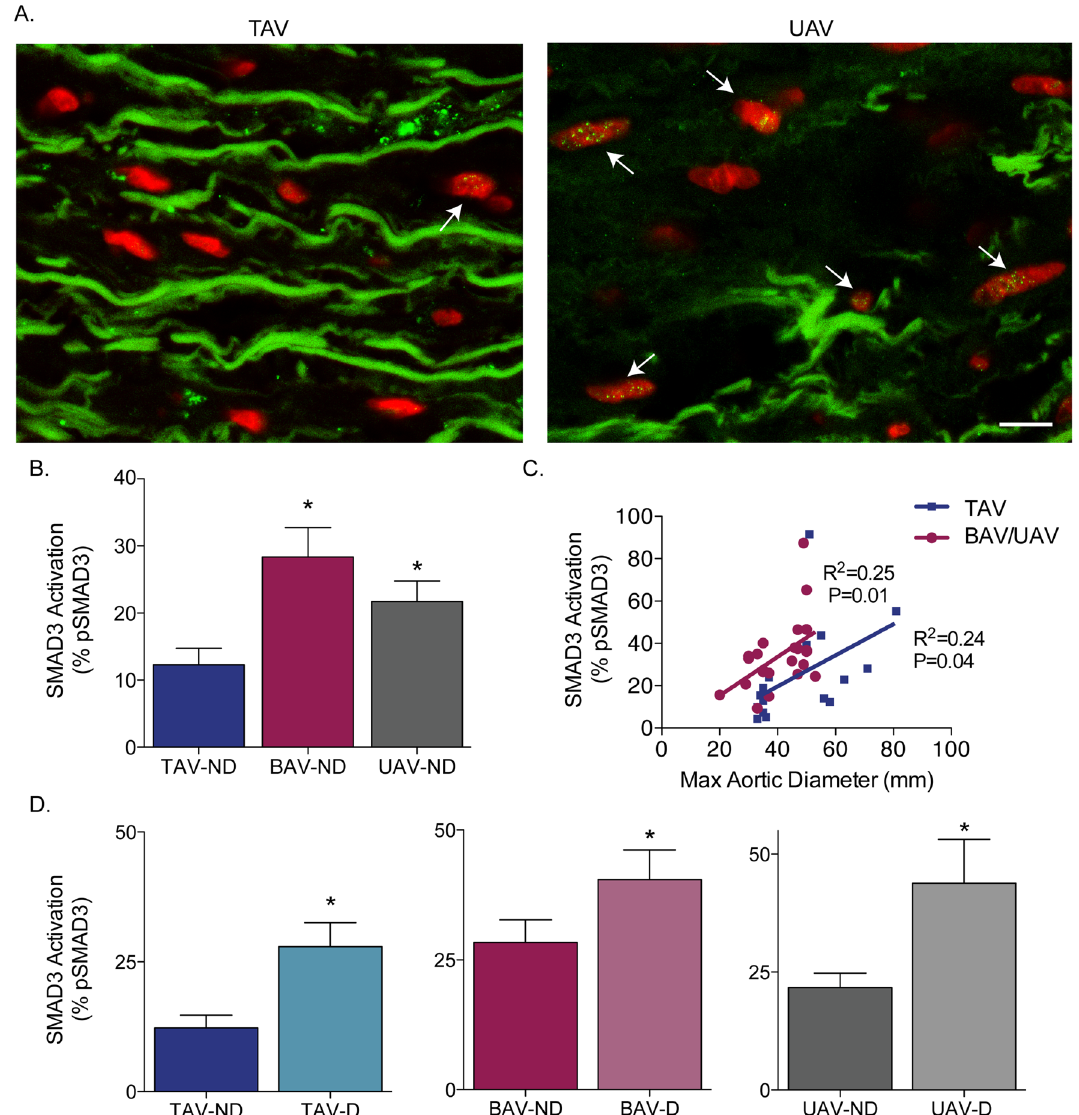
Figure 3. SMAD3 phosphorylation is increased in non-dilated bicuspid (BAV) and unicuspid (UAV) aortic valve aortas, and increases with dilatation in tricuspid aortic valve (TAV) and BAV/UAV aortas. ( A ) Fluorescent micrographs of ascending aortic cross-sections immunolabeled for phosphorylated SMAD3 (green points inside nuclei, indicated by white arrows) and counter-stained with DAPI (red). ( B ) Graph depicting the percentage of phosphorylated SMAD3 (pSMAD3)-positive smooth muscle cells in non-dilated (ND) aortas from individuals with a TAV, BAV or UAV. ( C ) Graph depicting the relationship between pSMAD3 and maximal ascending aortic diameter in TAV (blue) and BAV/UAV (pink) aortas. ( D ) Graphs depicting the percentage of pSMAD3-positive SMCs in ND and D aortas from individuals with a TAV, BAV or UAV. *P < 0.05. Scalebar = 10